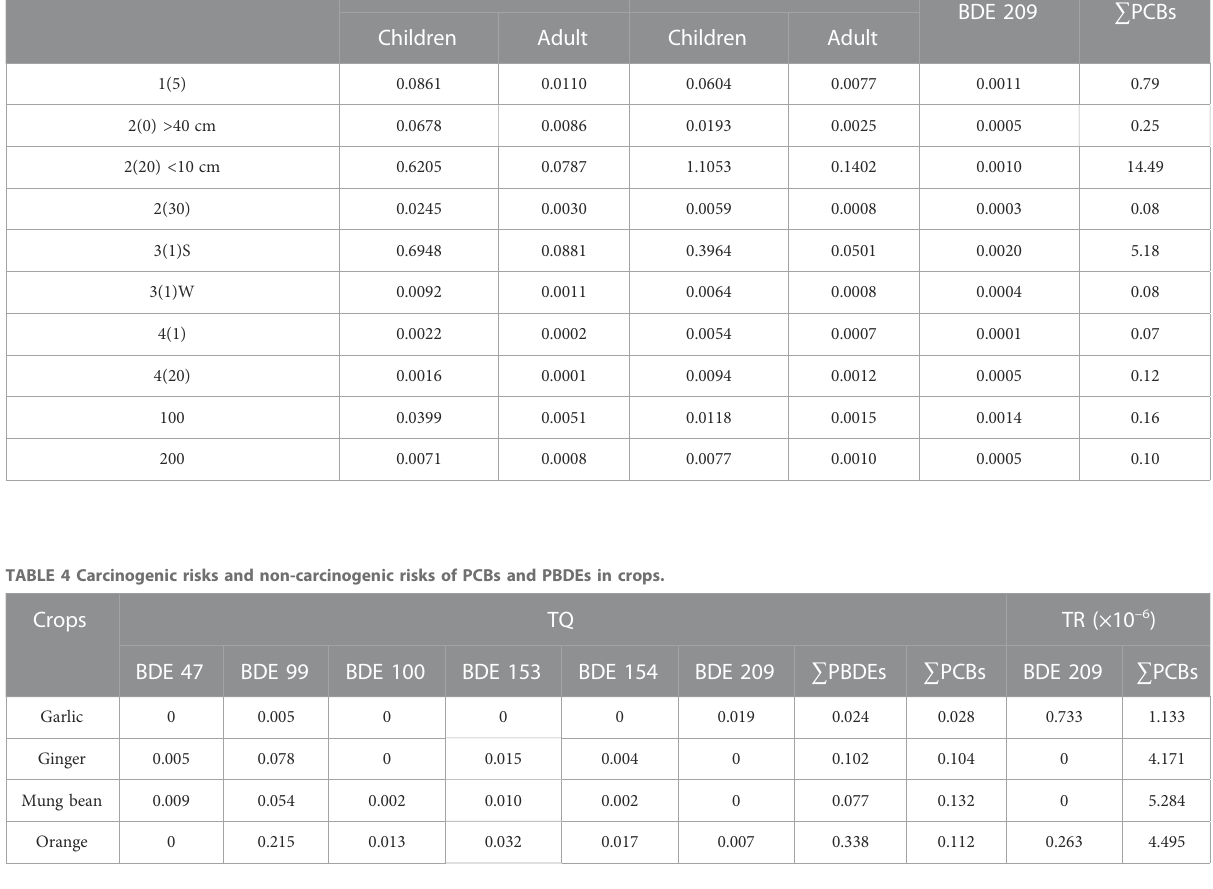
Sampling cites and